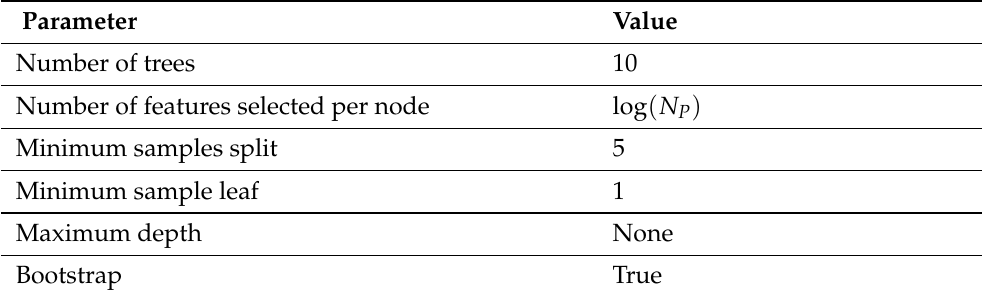
Table 1. Optimized values for the RF